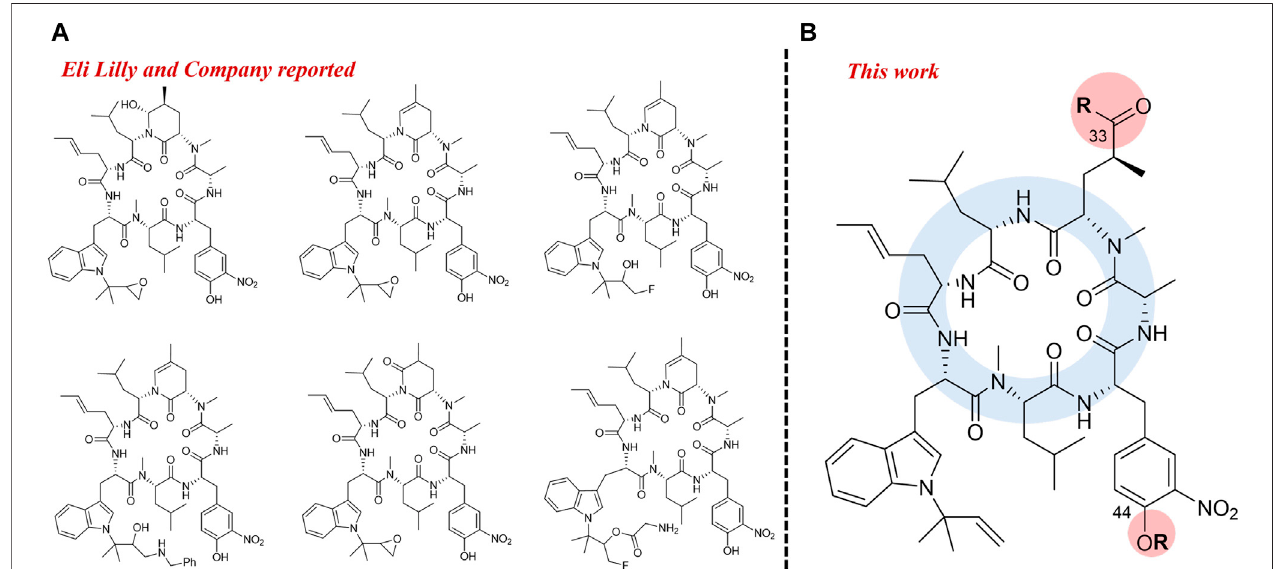
FIGURE 1 | Semi-synthesis of rufomycin active derivatives from Eli Lilly and Company (A) Modi fi ed position from this work (B) .